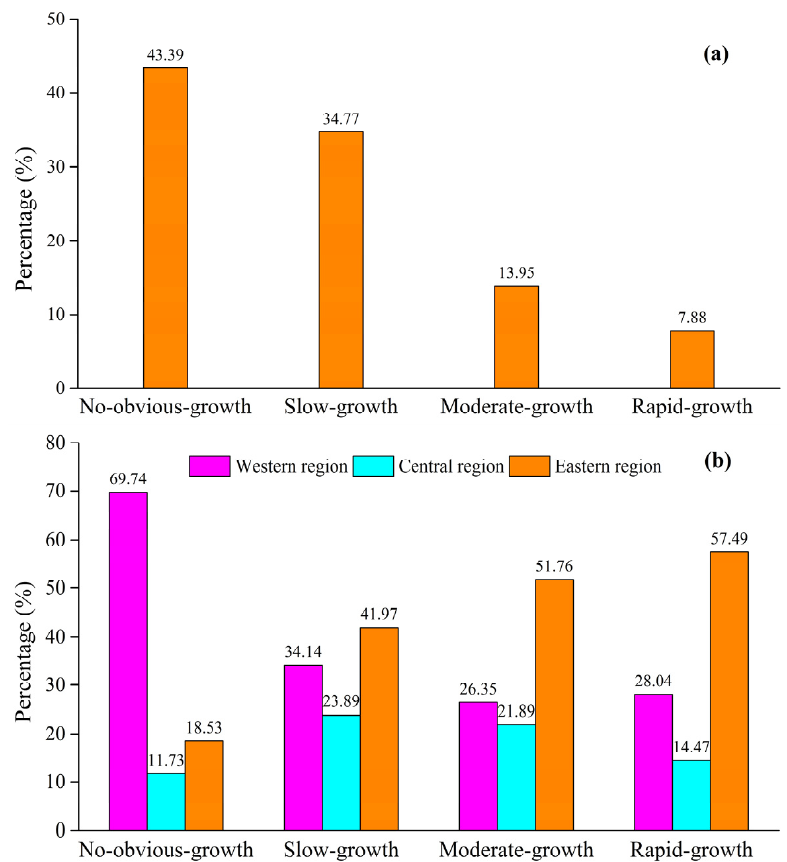
Figure 5. Four classes of the increments of energy consumption in China for 1995–2016 (Note: the non ‐ positive growth was masked).